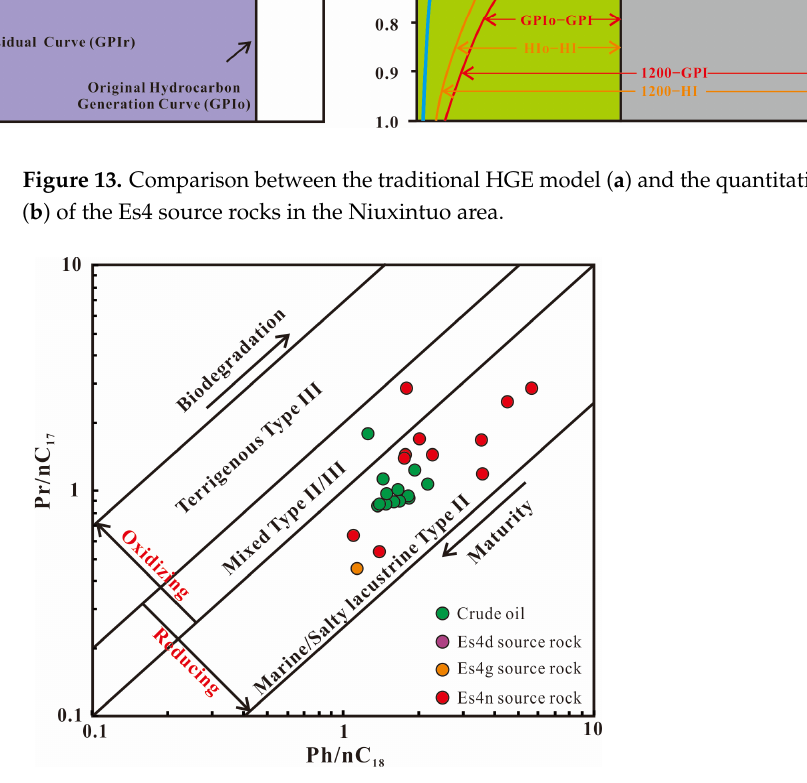
Figure 13. Comparison between the traditional HGE model ( a ) and the quantitative optimized model ( b ) of the Es4 source rocks in the Niuxintuo area.